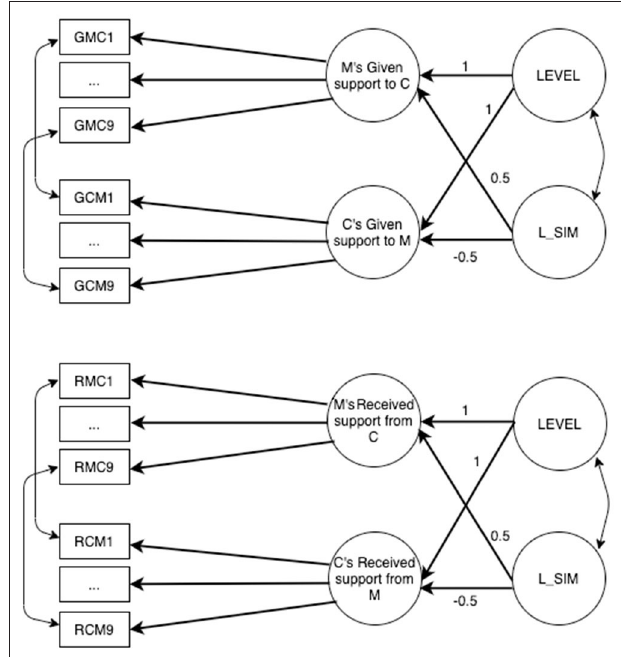
FIGURE 2 | Similarity LCM referred to mother–child given support M, mother; C, child. GMC1–GMC9, items assessing the support given by the mother; GCM1–GCM9, items assessing the support given by the child; LEVEL, average (mean) level of the mother and child perceptions of given support (second-order factor); L_SIM, lack of similarity (second-order